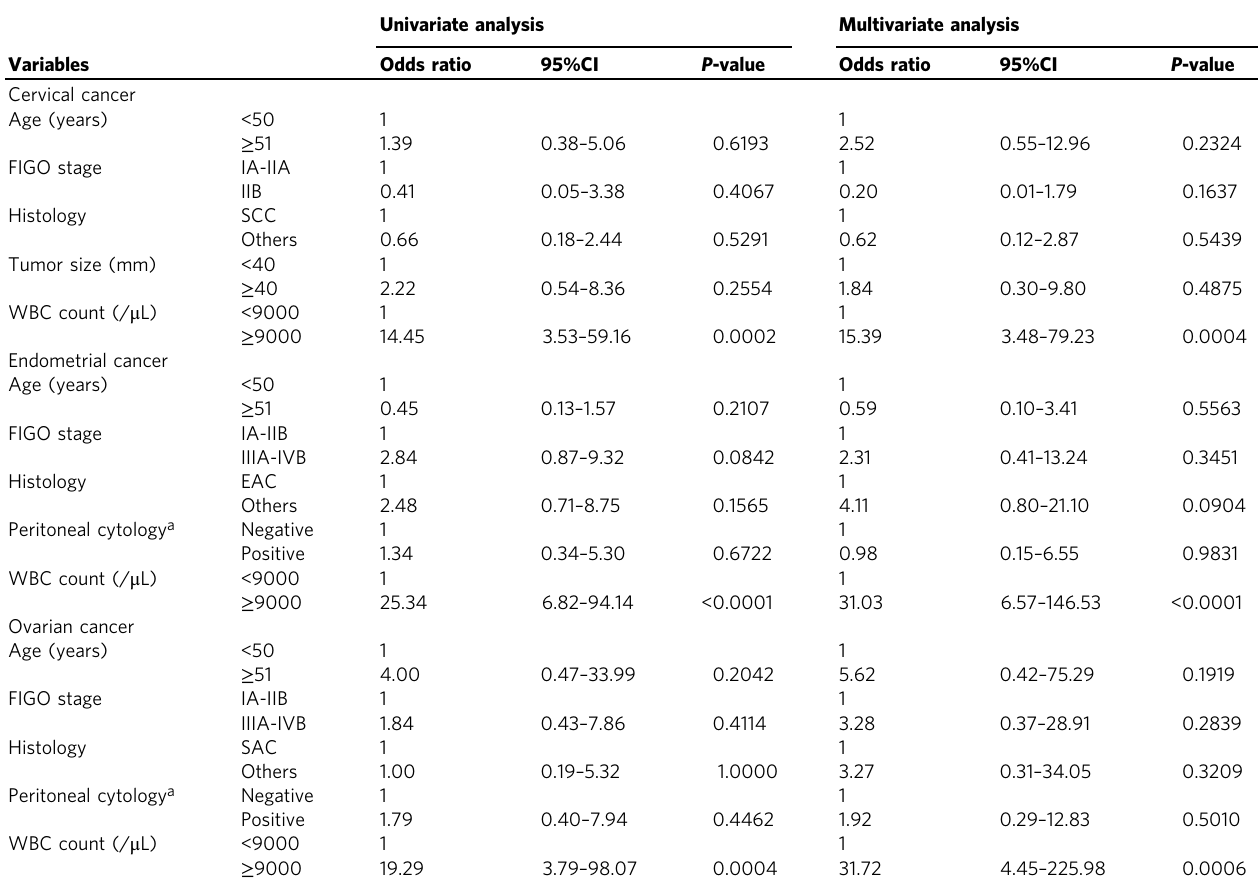
Table 3 Univariate/multivariate analyses for false-positive 18F-FDG-PET/CT results.